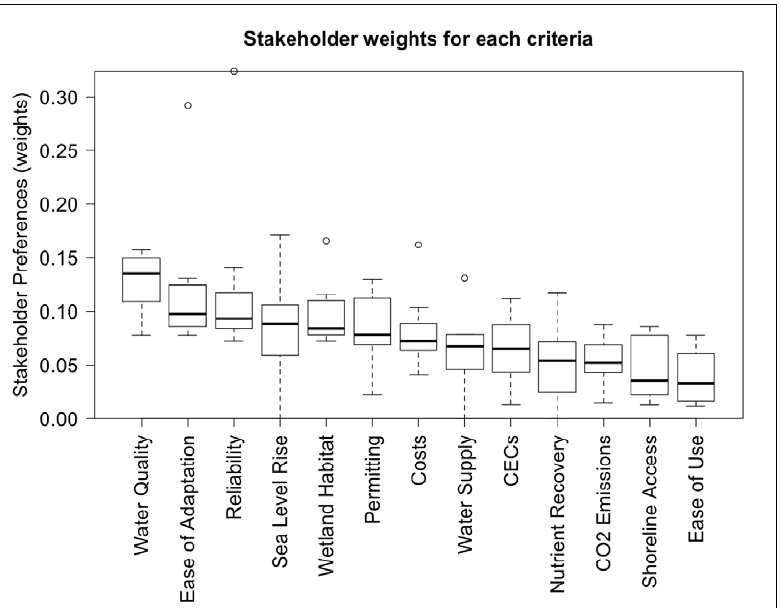
Figure 2. Relative weights of goals for Bay Area nutrient management derived from interviews with nine stakeholders. Boxplot midlines denote median values of responses, boxes represent the interquartile range, and whiskers extend to 1.5 times the interquartile range. Outliers are marked with a circle. Each stakeholders’ total weights are added to